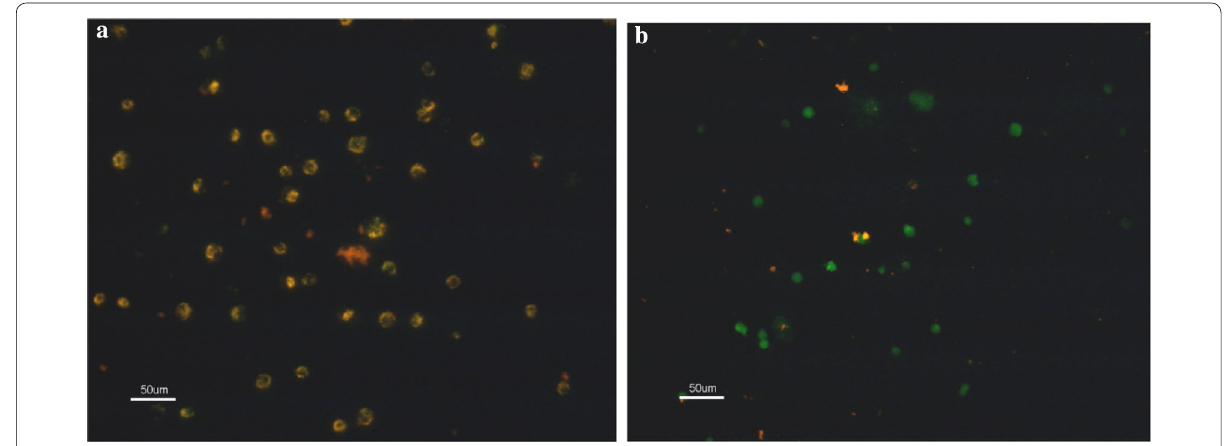
Fig. 5 Mitochondrial membrane potential of ( a ) untreated and ( b ) treated K562 cells. Almost all cells in the control group showed more red fluores- cence, while the lipopeptide-treated cells displayed green fluorescence. The scale bar is 50